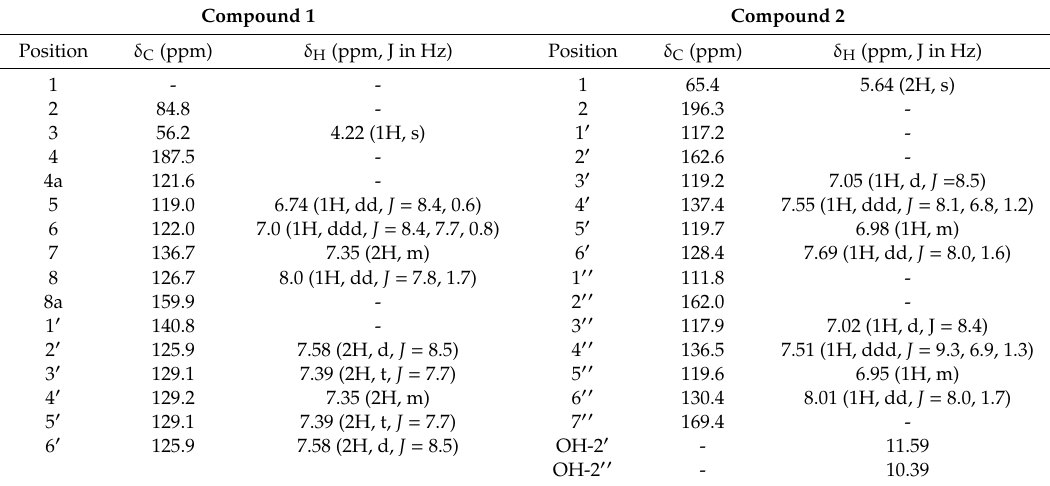
Table 1. 1 H- and 13 C-NMR Spectroscopic Data of 1 and 2 in CDCl 3 ( 1 H 600.19 MHz, 13 C 150.91